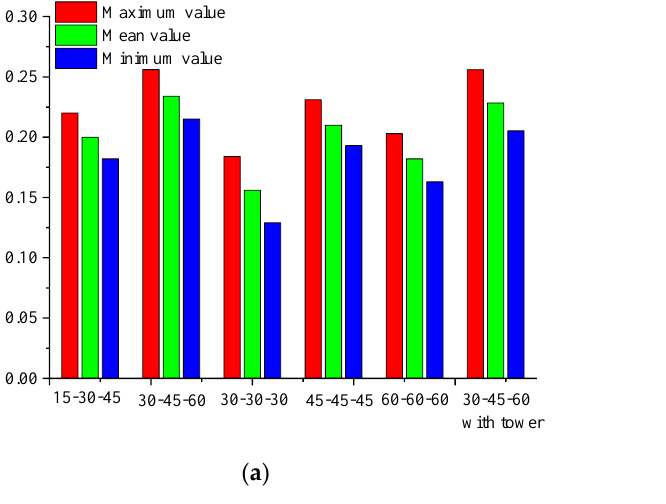
Figure 13. Maximum, minimum, mean